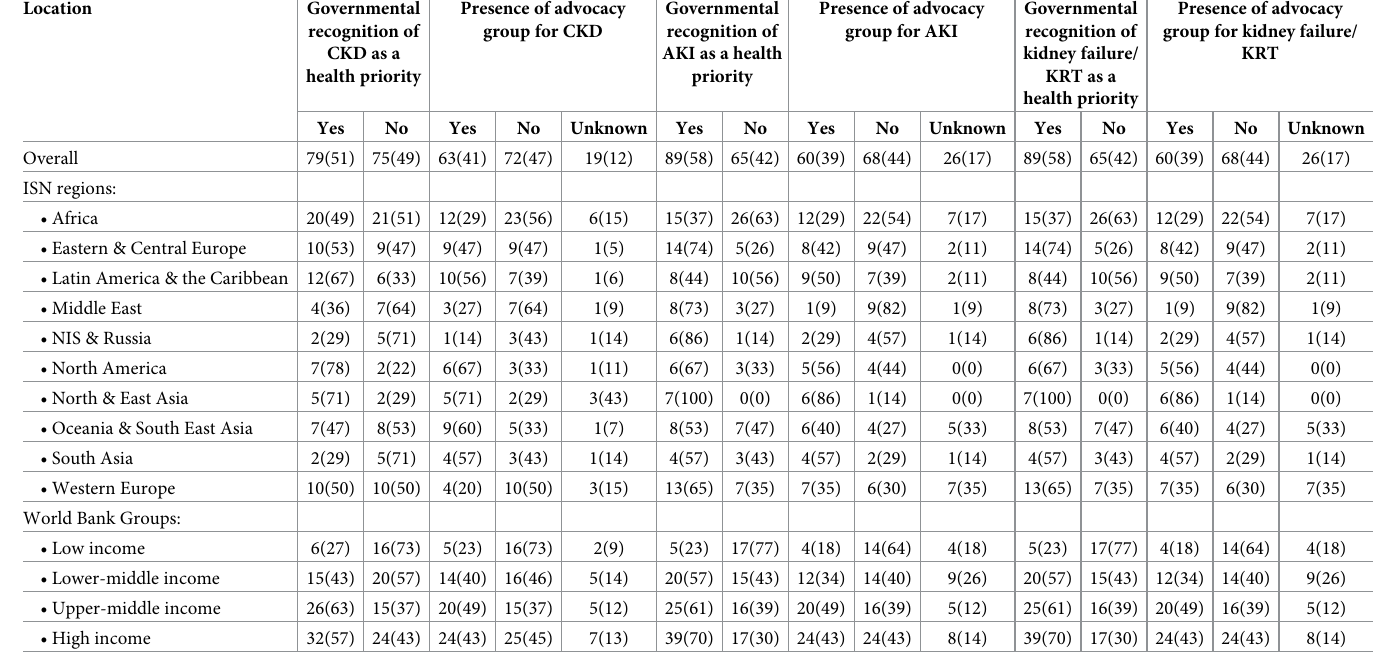
Table 3. Government prioritization of, and presence of advocacy groups for AKI, CKD, and kidney failure treatment and prevention around the world. Numbers represent countries (%).